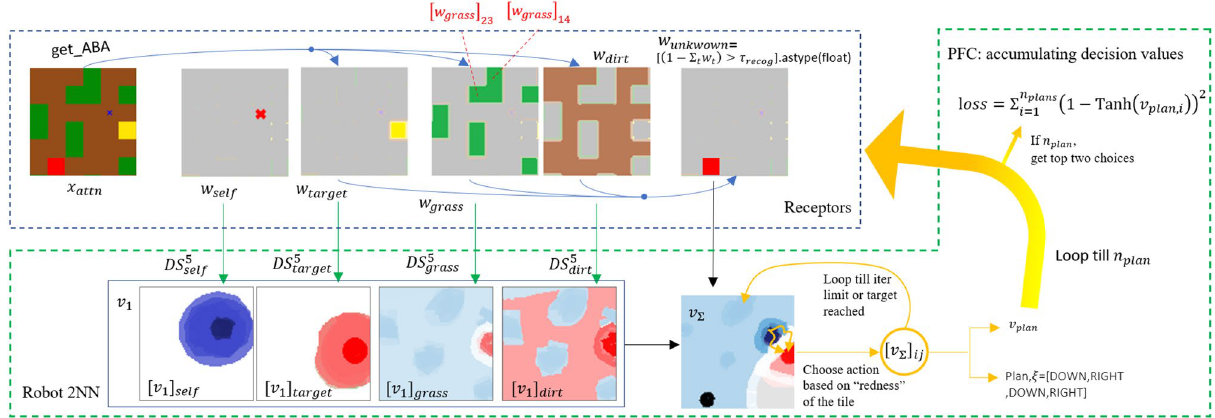
Figure 5. Robot2NN schematic. Receptors help split incoming signals for further processing. x attn (the whole visible map) and w self (the agent’s position) are the direct input to the model. In v 1 , v (cid:31) , red values are positive (desirable), white zero and blue negative (not desirable). PFC (green dotted box) contains trainable series of parameters to make and adjust decisions. [ w grass ] 14 , [ w grass ] 23 are examples of strong activations that are interpretable through tile-based